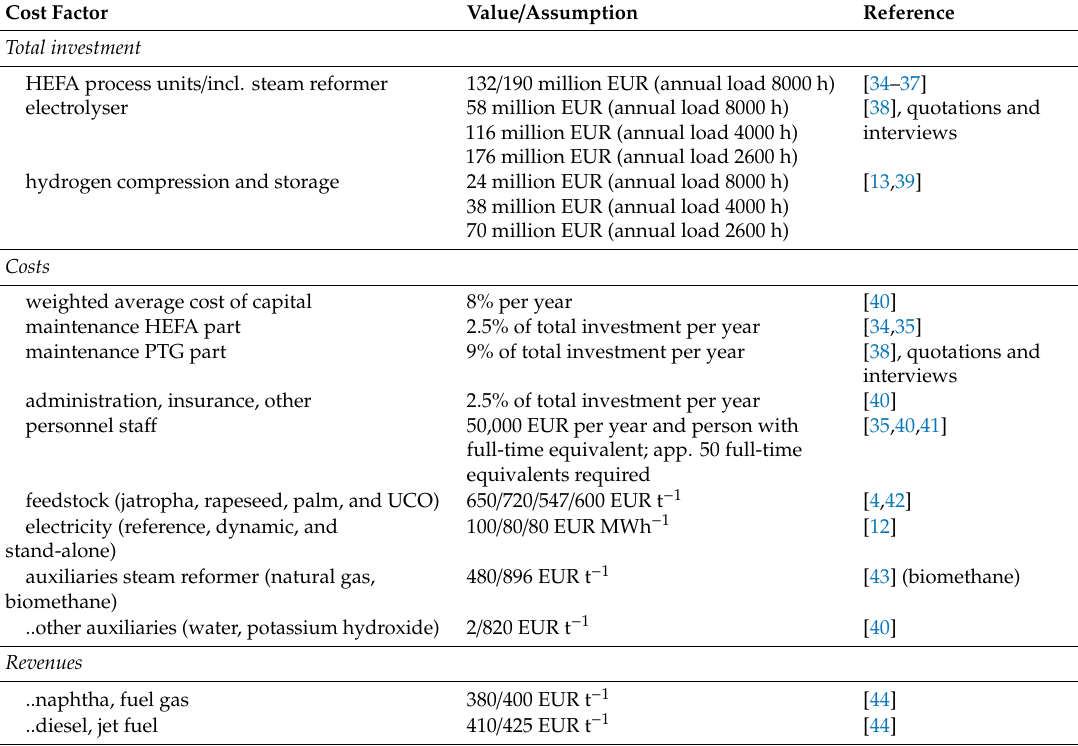
Table 3. Main assumptions for fuel production cost calculation (reference year 2015, assessment period 30